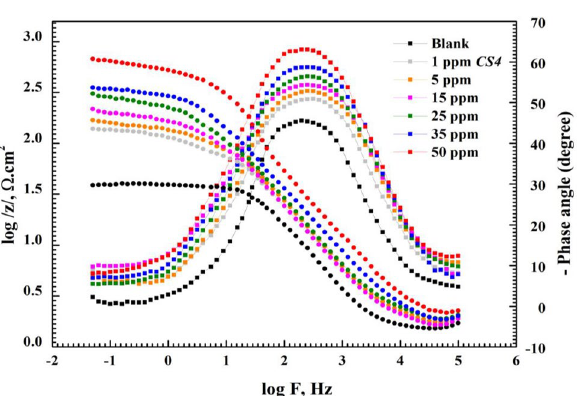
Figure 5. Bode and phase diagram for CS -metal in 1 M HCl in the absence and presence of various concentrations of